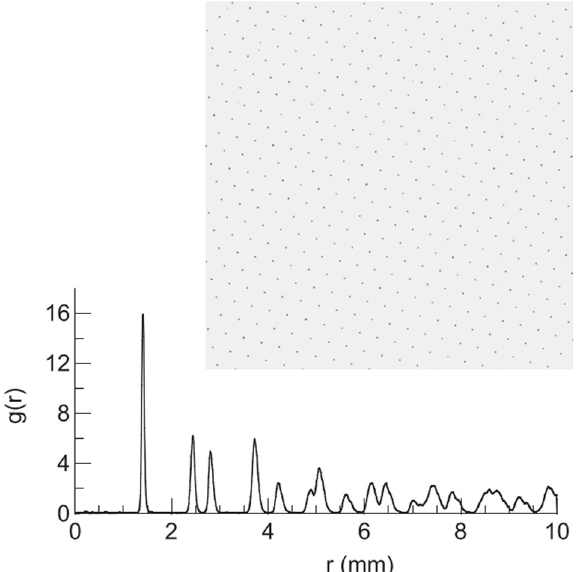
Fig. 1 The plasma crystal. Snapshot of a 2D complex plasma crystal showing about 400 particles (upper panel) and the pair correlation function g(r) as a function of the inter-particle distance r (lower panel). The image is inverted and its brightness is adjusted for better viewing 6 .